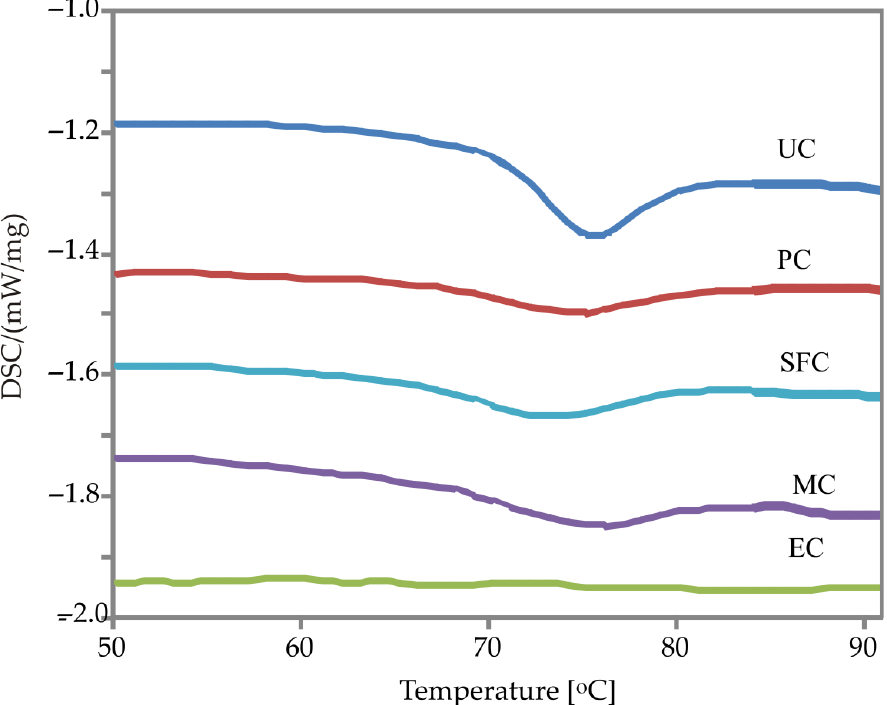
Figure 1. DSC thermograms of unprocessed and heat-treated corn samples (UC-unprocessed corn; PC-pelleted corn; SFC-steam-flaked corn; MC-micronized corn; EC-extruded corn).